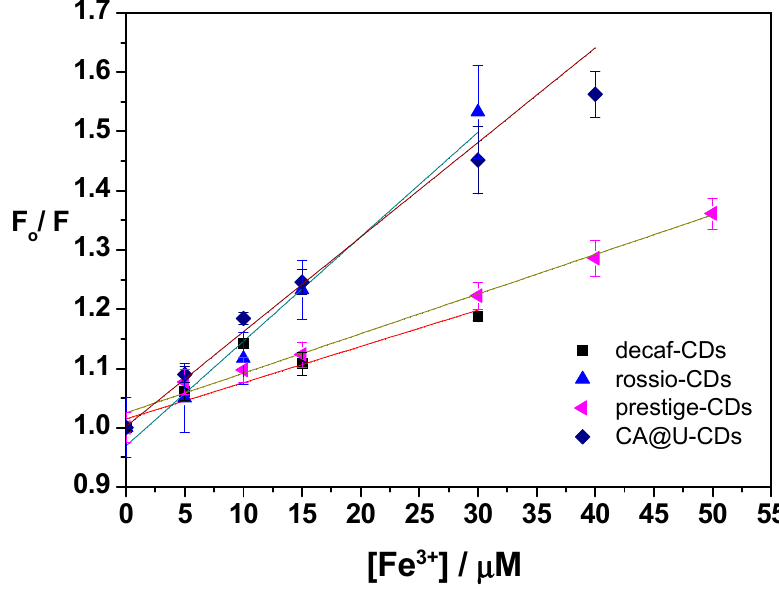
Figure 4. Emission profiles of ( ■ ) decaf-CDs, ( ◄ ) prestige-CDs, ( ♦ ) CA@U-CDs ( ▲ ) and rossio-CDs (d) as a function of the concentration of Fe 3 + (in mM), in aqueous solution. F 0 and F are the relative fluorescence intensities in the absence and presence of Fe 3 + , respectively. R 2 = 0.85; 0.98; 0.98 and 0.96,